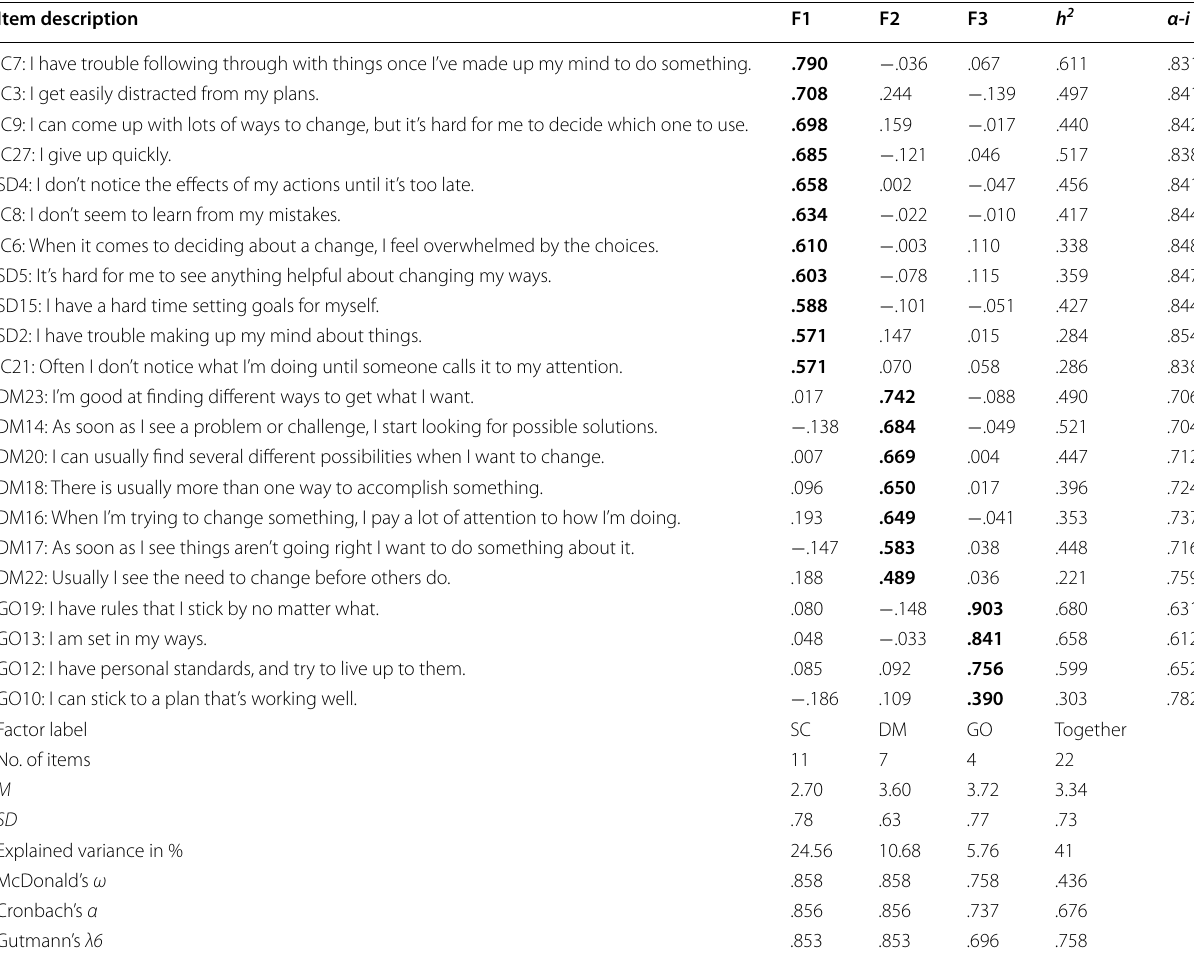
Table 2 Pattern matrix of the SRQ-CZ ( n